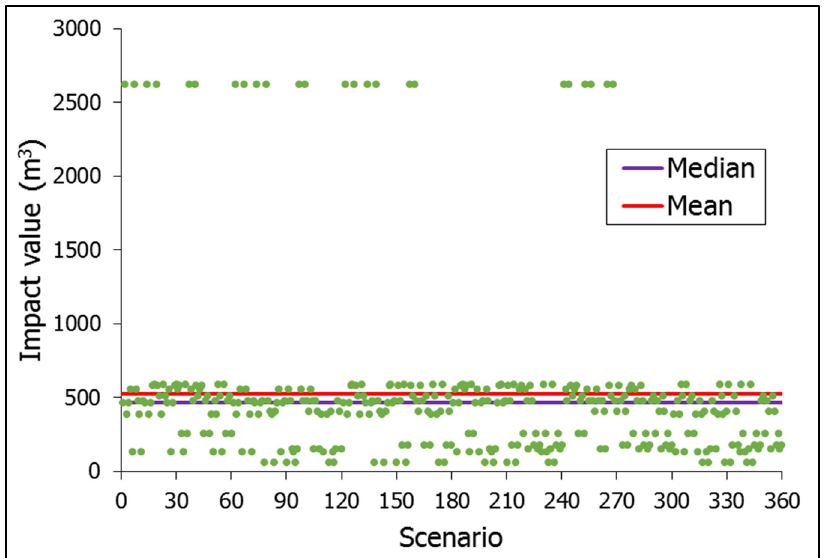
Figure 6. Impact values (green circles) corresponding to the scenario under which the designed OCMS with η total = 6 is subjected to a cyber-physical attack ( η attack =